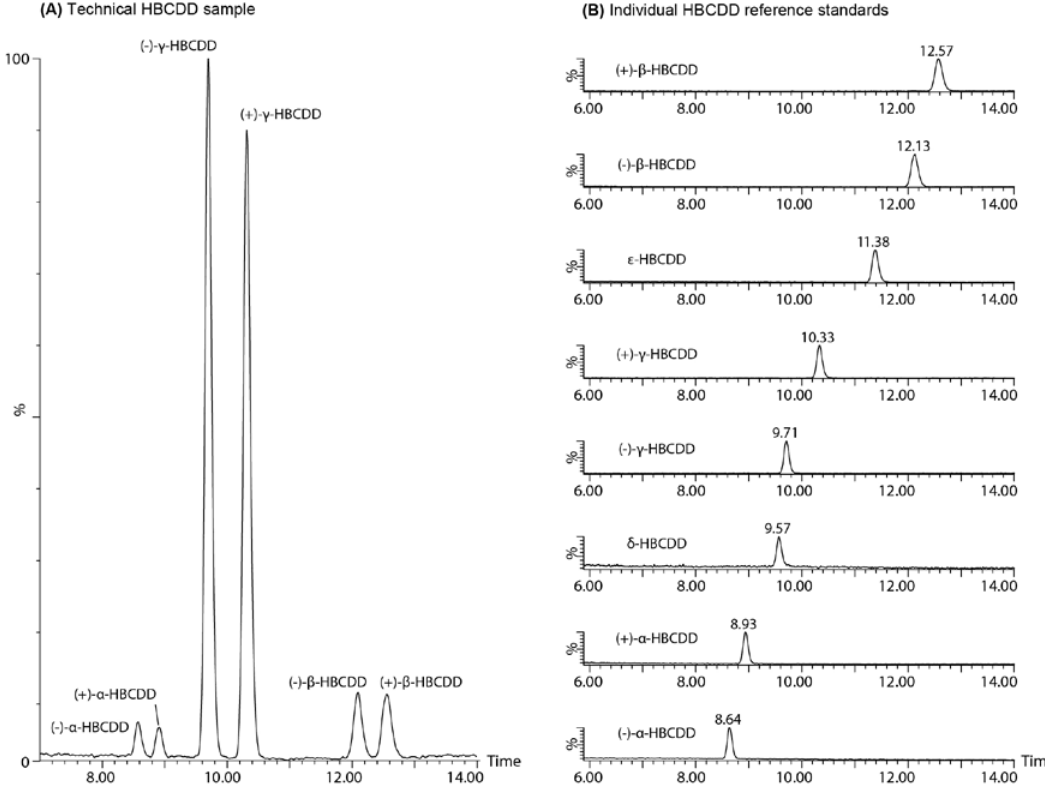
Figure 3. Analytical scale pSFC-MS separation of ( A ) a technical HBCDD mixture and ( B ) the isolated α-, β-, and γ-HBCDD enantiomers as well as reference standards for δ- and ε-HBCDD on a Trefoil CEL2 [cellulose tris-(3-chloro-4-methylphenylcarbamate)] stationary phase at 50 °C using an isopropanol modified carbon dioxide mobile phase.